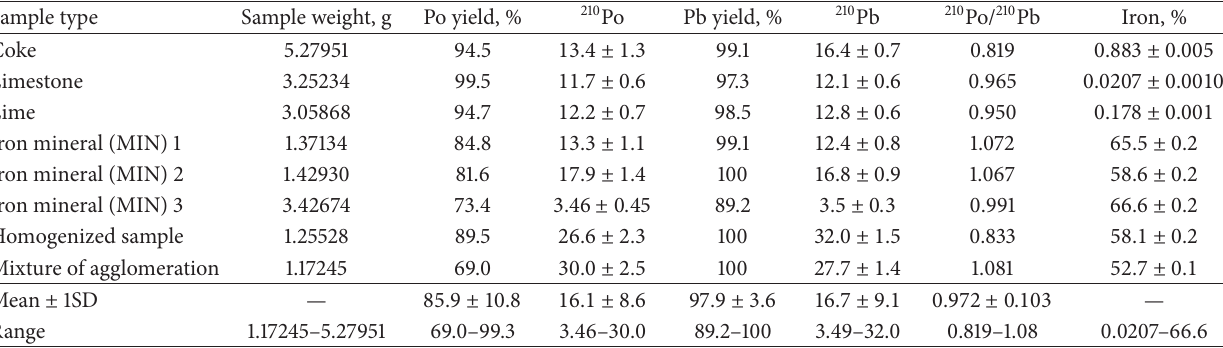
Table 6: The 210 Po and 210 Pb concentrations in Bqkg − 1 and iron concentrations in raw material samples collected from the ILVA Taranto